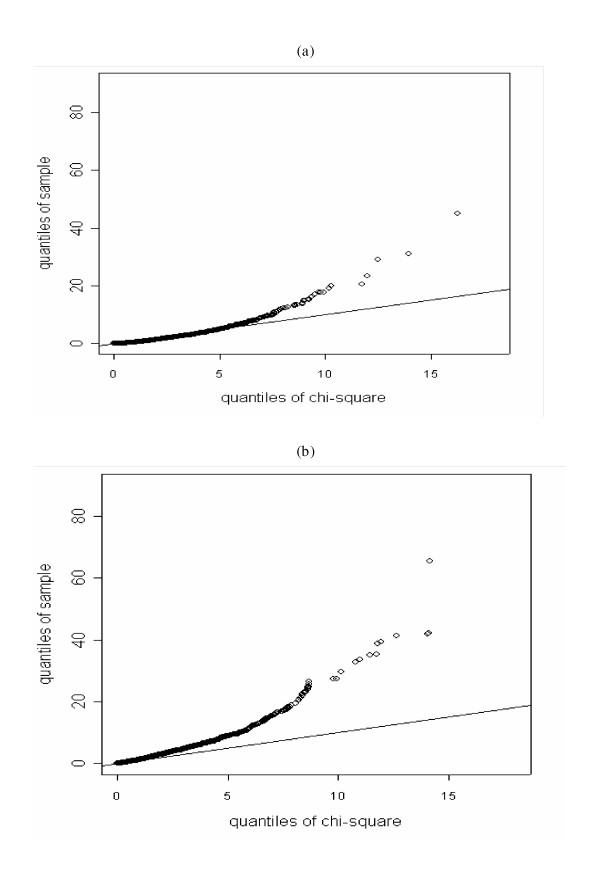
Quantile – Quantile plots of the observed versus the expected Q statistic: (a) with quality adjustment, and (b) without quality adjustment.